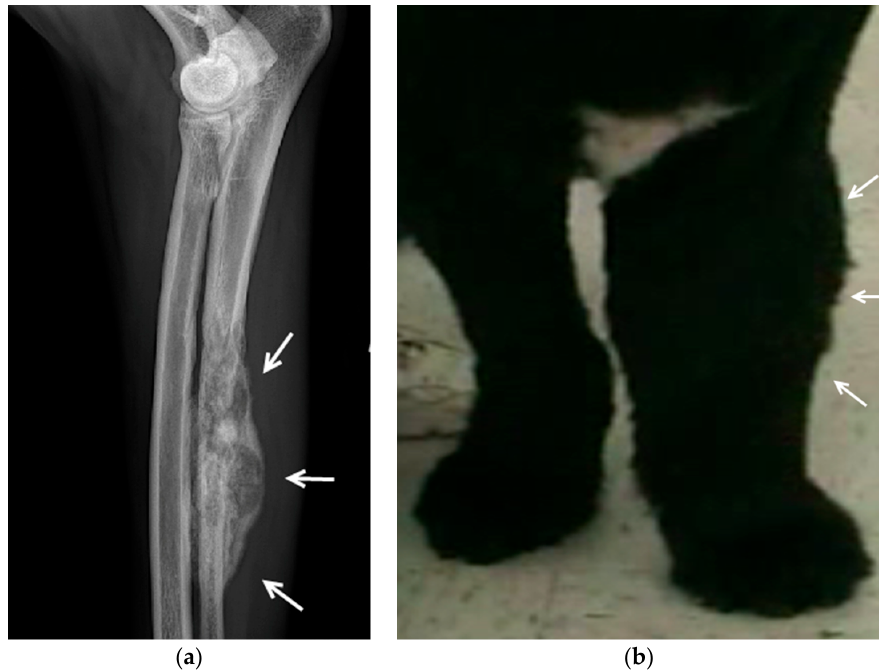
Figure 1. An example of canine bone cancer: ( a ) A radiograph of the left radius and ulna reveals a severe moth eaten osteolytic lesion of the ulna (white arrows); ( b ) Compared to the right forelimb there is marked swelling of the left forelimb (white arrows) due to edema associated with the underlying bone tumor.